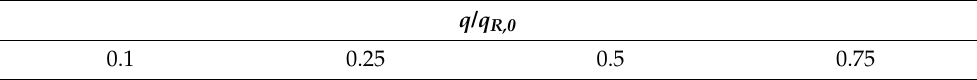
Table 2. Selected sustained load configurations for the examined glass panel.